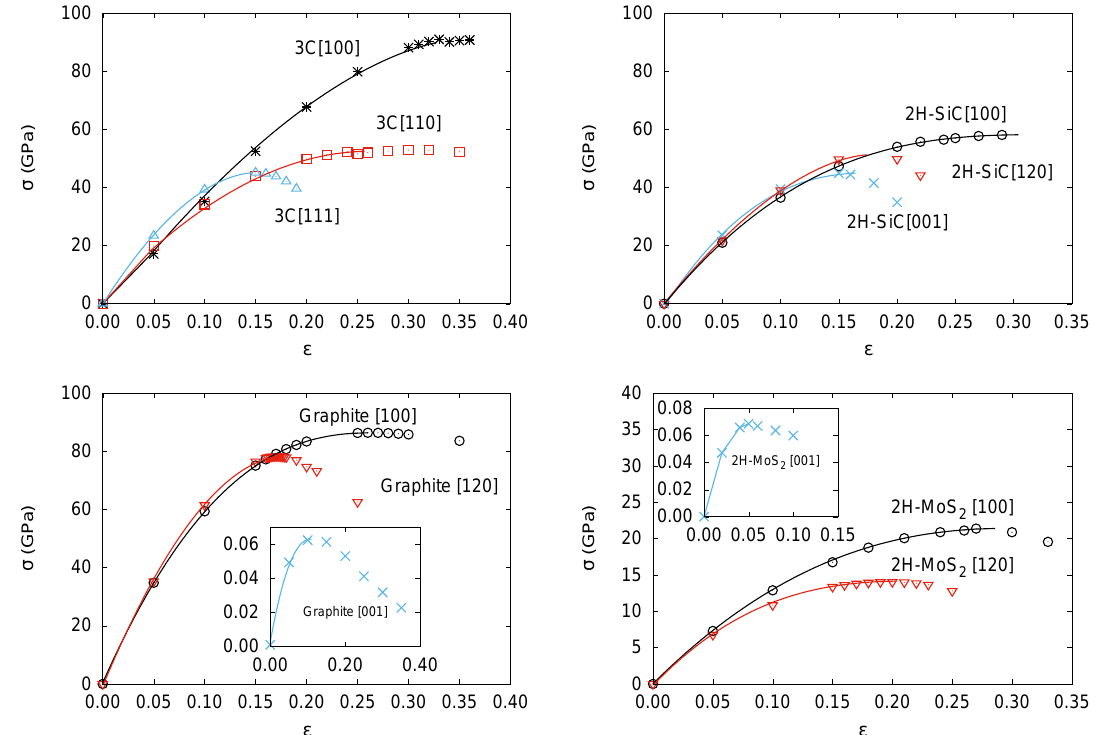
Figure 1. Calculated strain-stress curves without transverse stress for: 3C-SiC ( top left ), 2H-SiC ( top right ), Graphite ( bottom left ), and 2H-MoS 2 ( bottom right